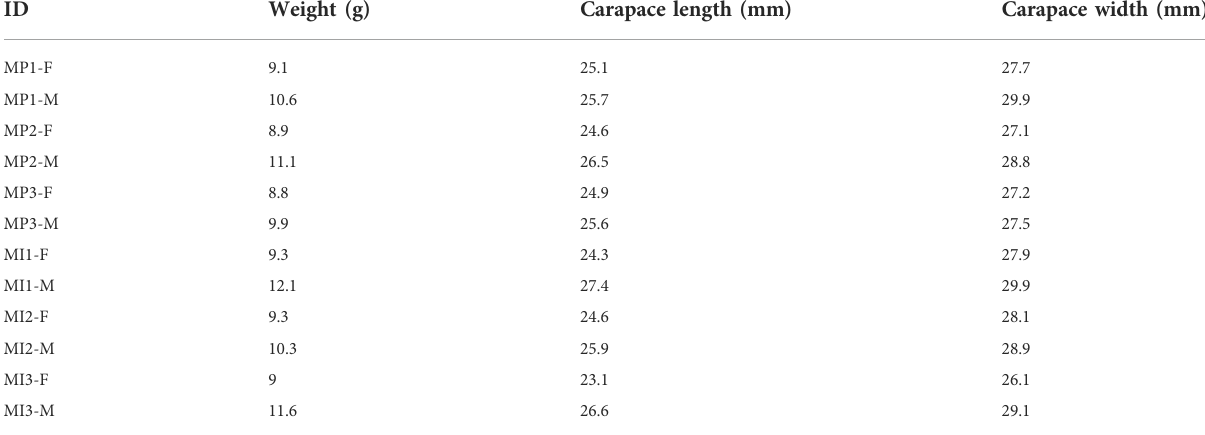
TABLE 1 Body size parameters for the E. sinensis study samples.